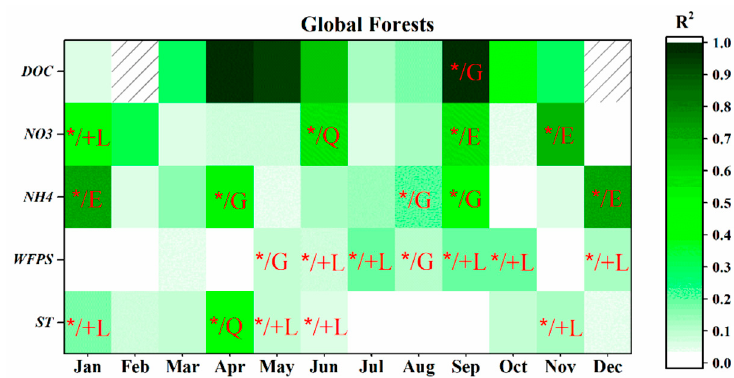
Figure 5. Heat map of the coefficients of determination ( R 2 ) of linear regression (L), quadratic regression (Q), logarithmic regression (G) or exponential regression (E) between N 2 O fluxes and soil temperature (ST), WFPS, NH4 (NH 4+ concentration), NO3 (NO 3- concentration), and DOC (DOC concentration) for global forests of each month. *Represents the significant relationship; +L and –L represent the positive and negative linear correlations, respectively.